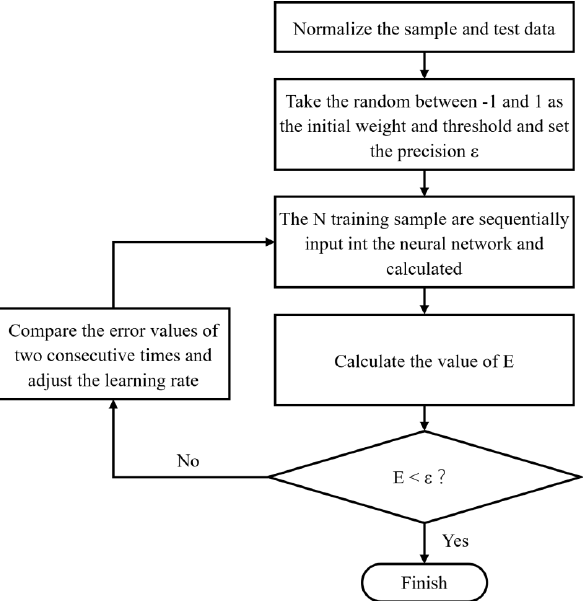
Figure 5. Prediction algorithm map of the spare parts consumption based on the BP neural network.